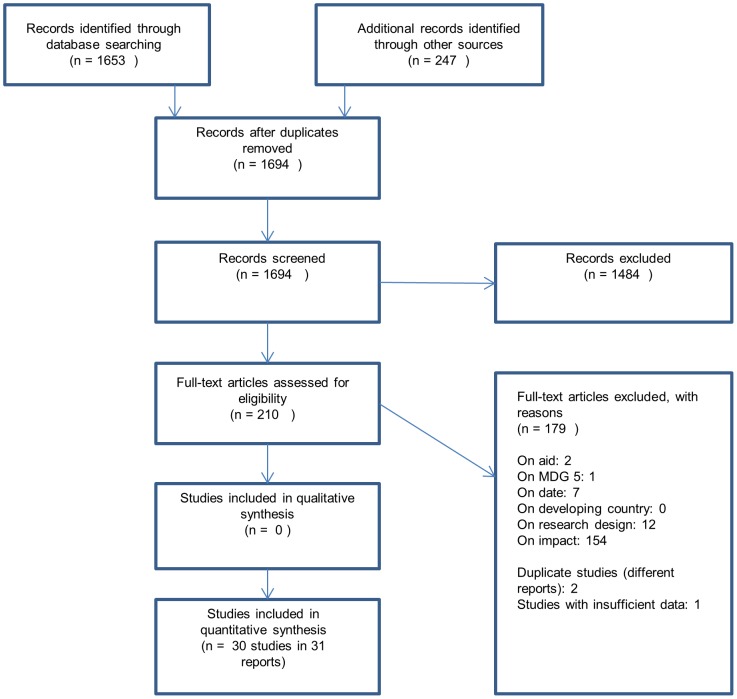
PRISMA flow diagram.